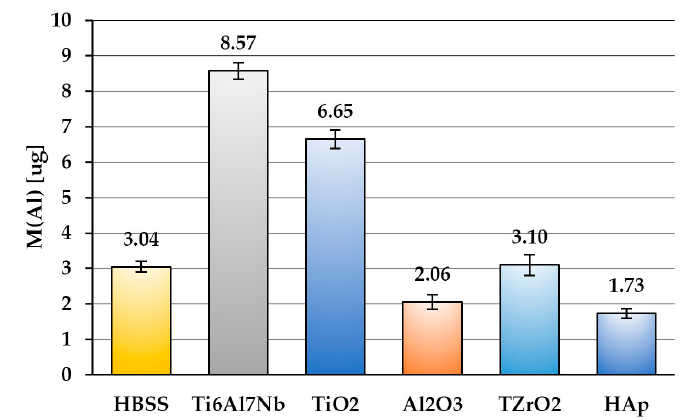
Figure 13. The mass of Al ions released into immersing solutions after a test.